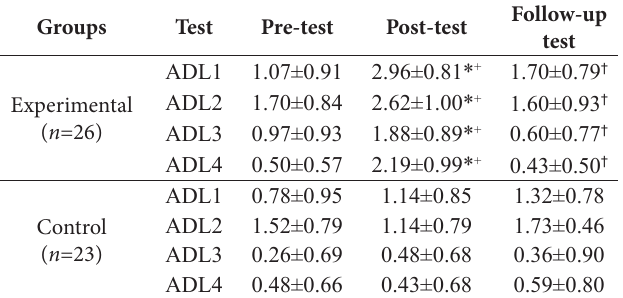
Table 2. Observation of school students’ ADL.